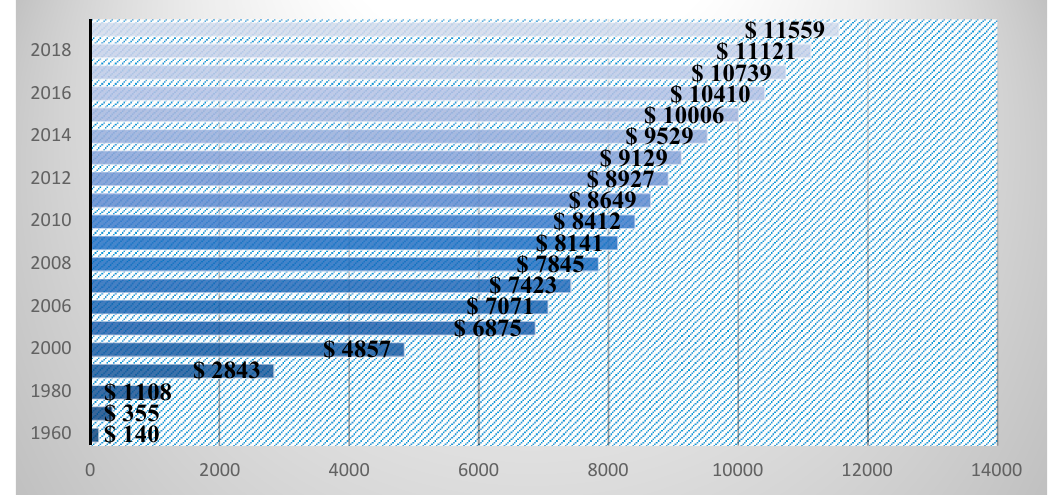
Figure 3. National healthcare expenditure per capita in the US .